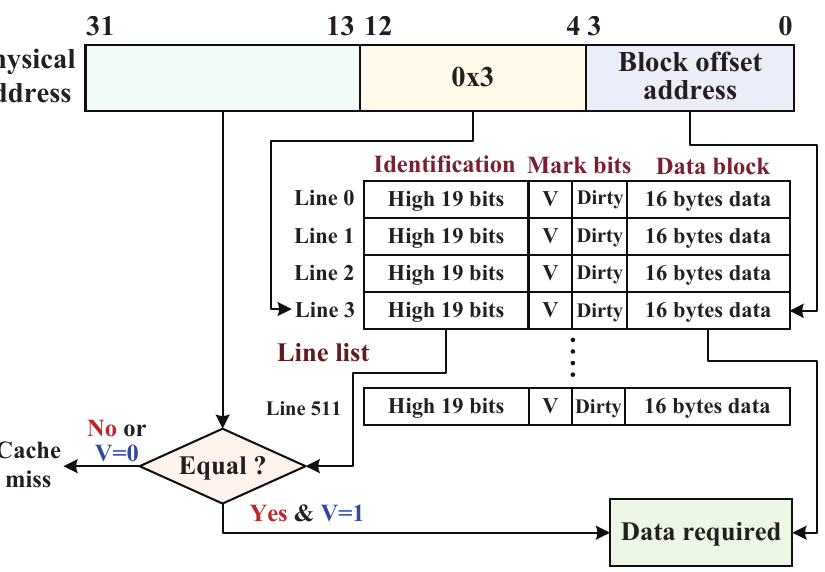
Figure 10. The implementation mechanism of the D-Cache with the size of